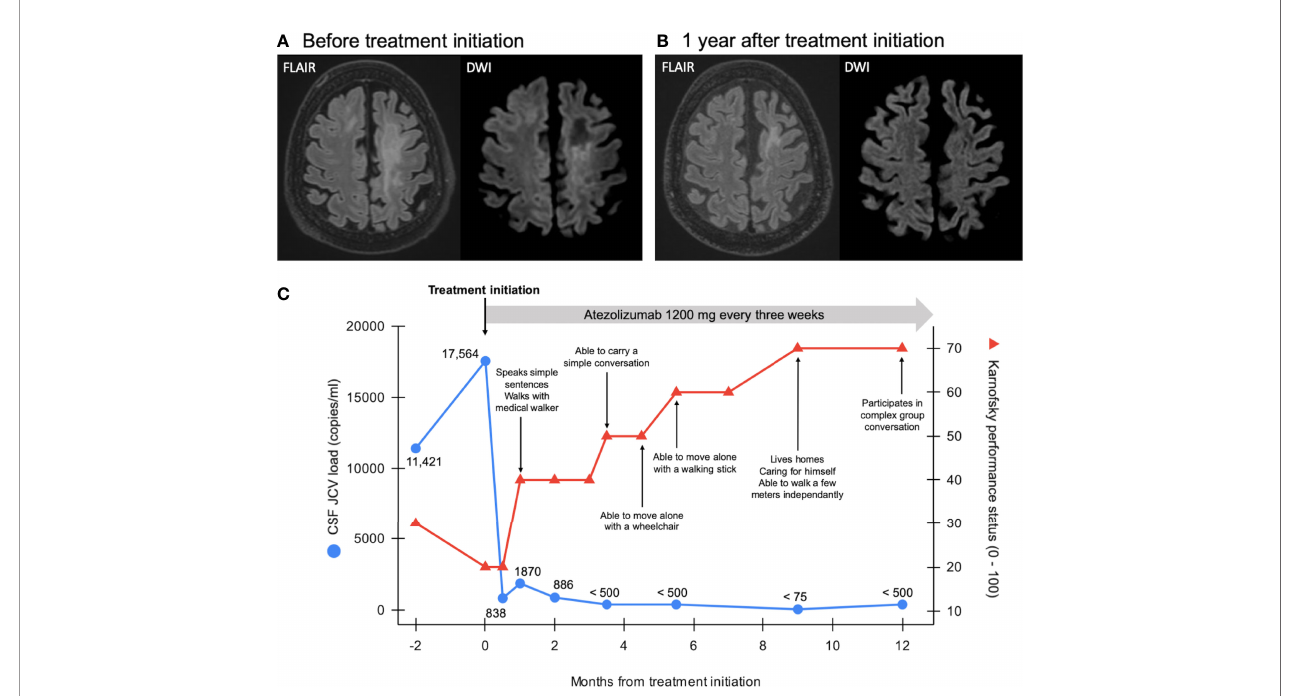
FIGURE 1 | Panel (A) Brain MRI scan at admission showing T2- fl uid attenuated inversion recovery (FLAIR)-weighted multifocal hyperintense white matter lesions with diffusion-weighted imaging (DWI, narrowed windowing for clarity purpose) ill-de fi ned hyperintense edges and hypointense core in keeping with disease activity. Panel (B) Brain MRI scan 1 year after treatment initiation showing regression of the T2/FLAIR hyperintense lesions and disappearance of the DWI (narrowed windowing) hypersignal, in keeping with gliosis (ADC not shown). Note progressive brain atrophy in previously affected areas. Panel (C) Patient ’ s clinical course and evolution of JC viral load in the cerebrospinal fl uid (CSF) over time. JC virus PCR assay ’ s quanti fi cation limit is 500 copies/ml; detection limit is 75